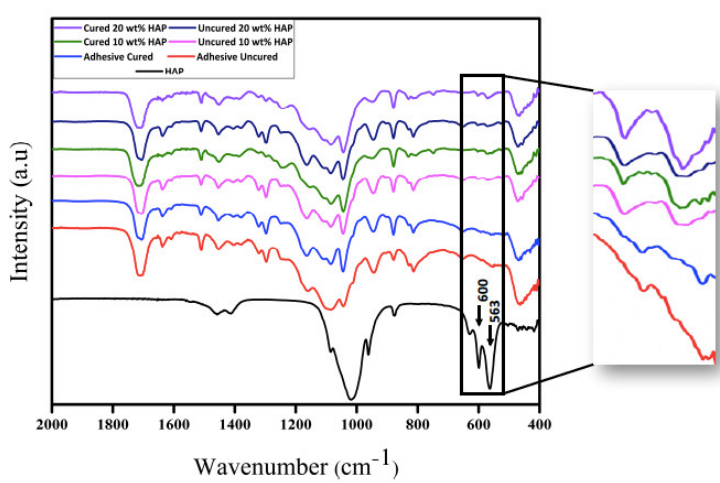
Figure 5. Fourier Transform-Infrared (FTIR) spectra of the n-HA particles, unmodified and modified experimental adhesives having low (5 wt %) and high (10 wt %) percentage of n-HA. The characteristic peaks at 563 and 600 cm −1 showing evidence of the presence of hydroxyapatite in the uncured and cured dentin adhesive. The representative Micro-Raman spectra of n-HA particles, CEA, and HAA-5% is shown in Figure 6A–C, respectively. The phosphate and carbonate groups could be identified in Figure 6A at 960 cm −1 and 1070 cm −1 correspondingly. For CEA, the presence of phosphate and carbonate groups is not clear (Figure 6B). The Micro-Raman spectra of HAA-5% group again demonstrates the presence of the phosphate group at 960 cm −1 and carbonate group at 1070 cm −1 (Figure 6C).